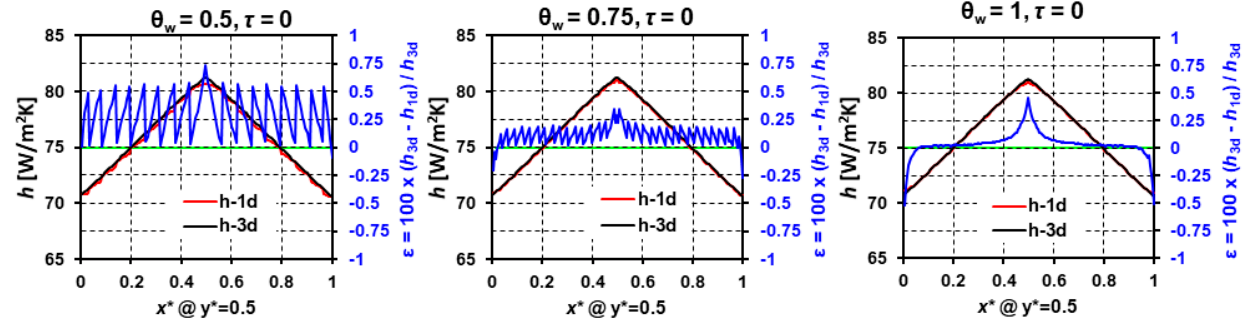
Figure 12. Method C, Case I: Local h variation at surface centerline and their relative % differences (Re ‐ 20,000, τ = 0).